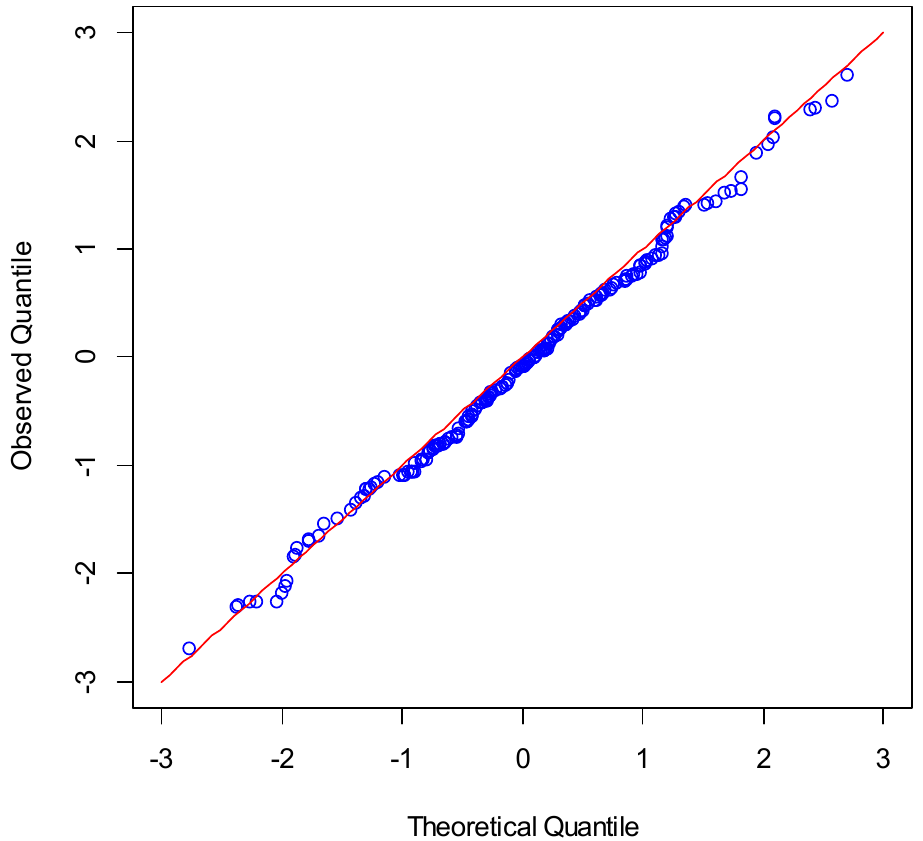
Figure 1. Normal probability plot of residuals for the BMLR model.